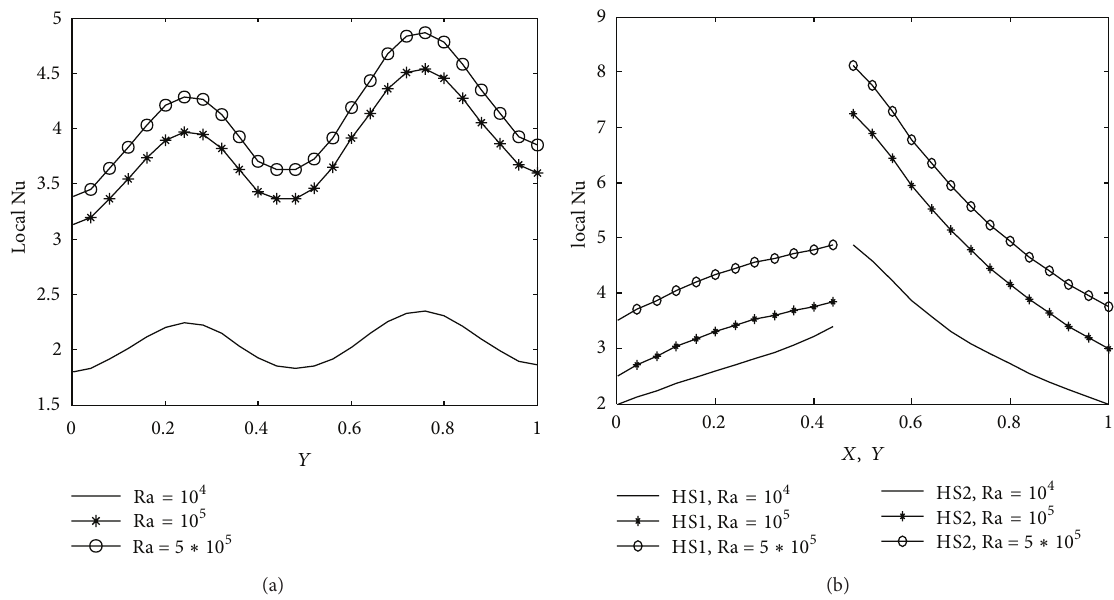
Figure 10: Variation of local nusselt number with Ra at Pr = 0.7 , 𝐴 = 0.2 , 𝑛 = 2 , ℎ𝑥 = 0.55 , and ℎ𝑦 = 0.55 (a) along cold wavy surface and (b) along the heaters.